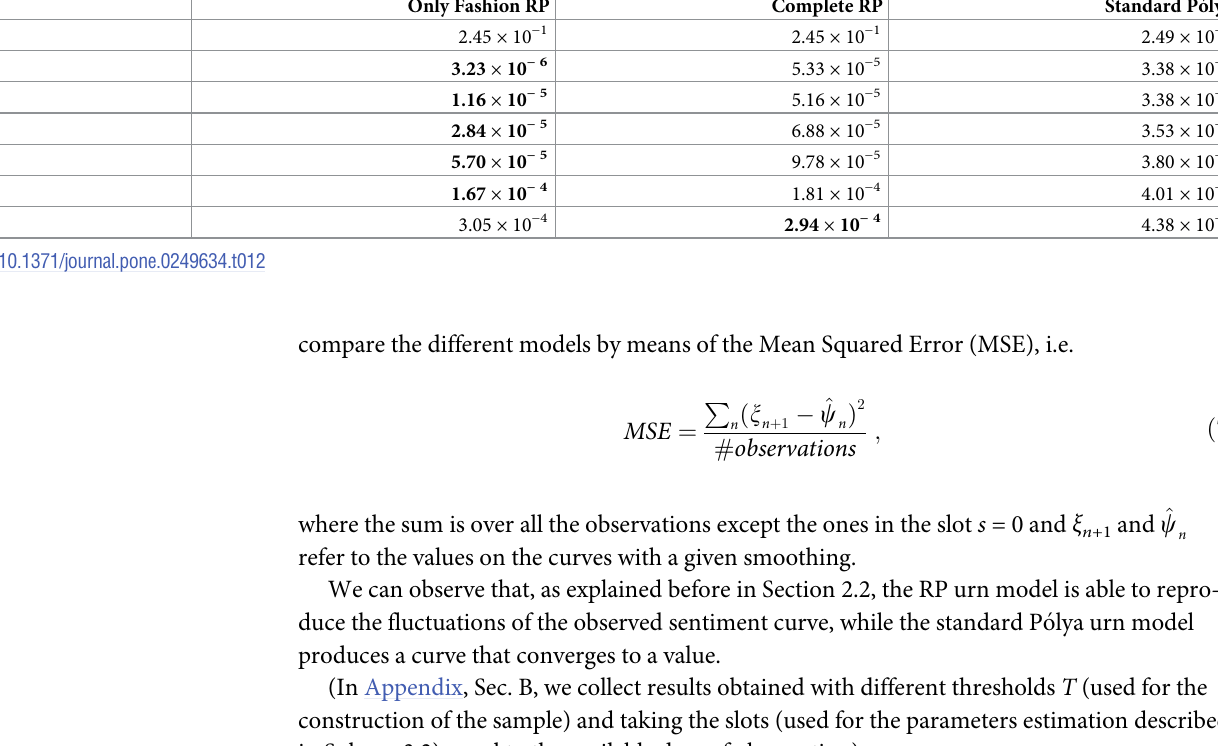
Table 12. “Covid” ( T = 0.35, only BOTs’ posts, D = 3 0 , S = 1000 slots of equal size): MSE for different levels of smoothing). smoothing Only Fashion